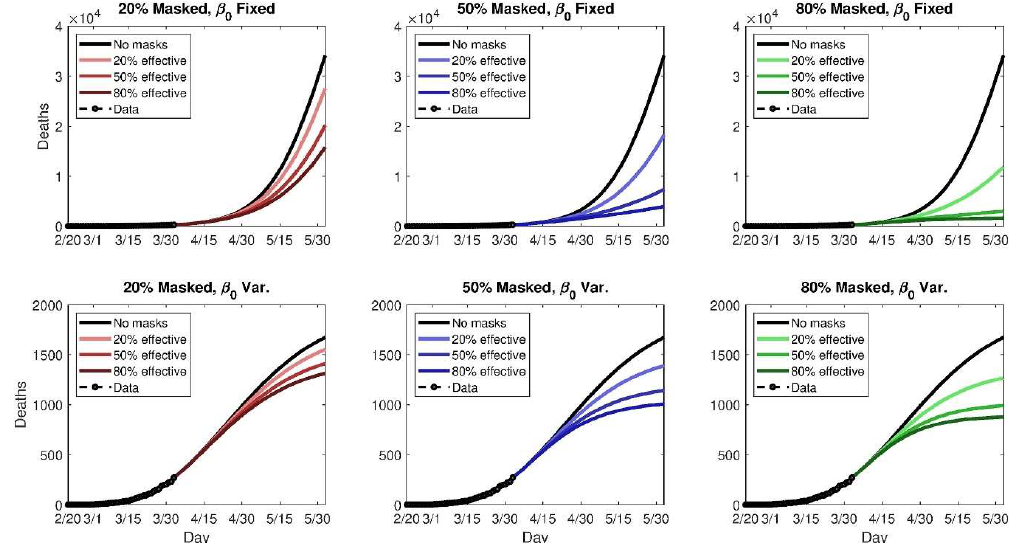
Figure 8. Simulated future (cumulative) death tolls for New York state, using either a fixed (top panels) or variable (bottom panels) transmission rate, β, and nine different permutations of general public mask coverage and effectiveness [66]. Reused under the terms of the Creative Commons Attribution License, crediting [69], KeAi 2020©.